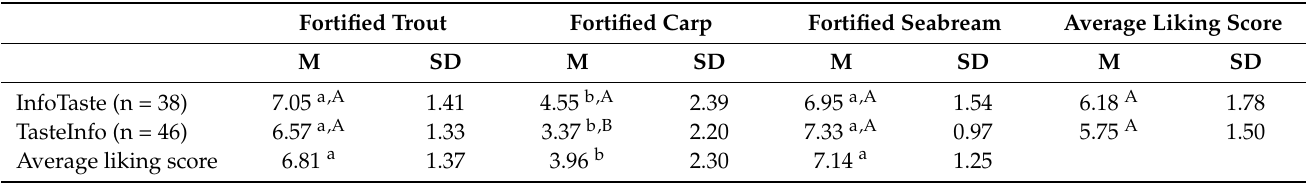
Table 4. Overall liking of fortified fish according to the rate of acquired information before sensory evaluation 1 Table 1. Demographic profiles of the sample of participants (n = 91).